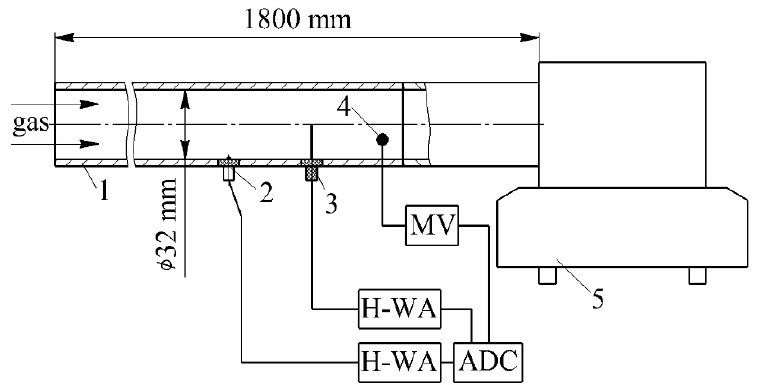
Figure 2. Diagram of the experimental setup for calibrating the measuring system: 1—pipeline (the length is 1.8 m and the inner diameter 32 mm); 2—hot-wire anemometer sensor for determining the local friction stress on the surface; 3—hot-wire anemometer sensor for determining the flow velocity; 4—thermocouple; 5—traction fan; MV—millivoltmeter; H-WA—electronic unit of the hot-wire anemometer; ADC—analog-to-digital